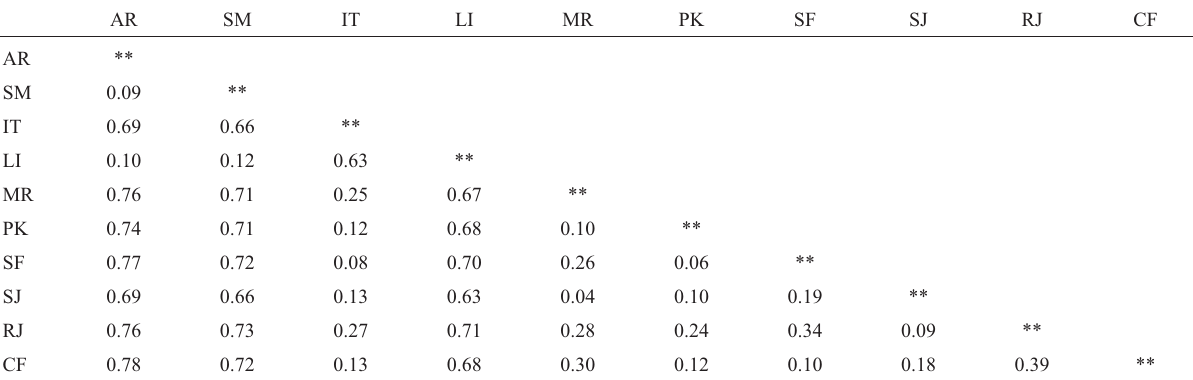
Table 3 - Matrix of pairwise genetic distances between the locations where samples of A. robusta were collected.